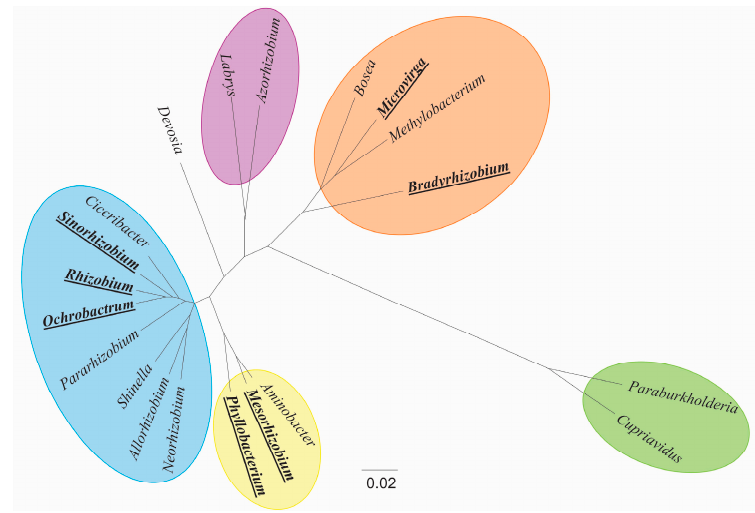
Figure 1. A Bayesian posterior probability consensus tree based on 1408 bps of 16S rRNA derived from 16 rhizobial and 4 related genera (the genera nodulating Genisteae are in bold case-underlined). The strains used for this construction and the 16S rRNA Genbank accession numbers were: Rhizobium leguminosarum ATCC 10004 (U29386), Sinorhizobium fredii ATCC 35423 (X67231), Allorhizobium undicola ATCC 700741 (Y17047), Pararhizobium capsulatum ATCC 43294 (X73042), Neorhizobium galegae